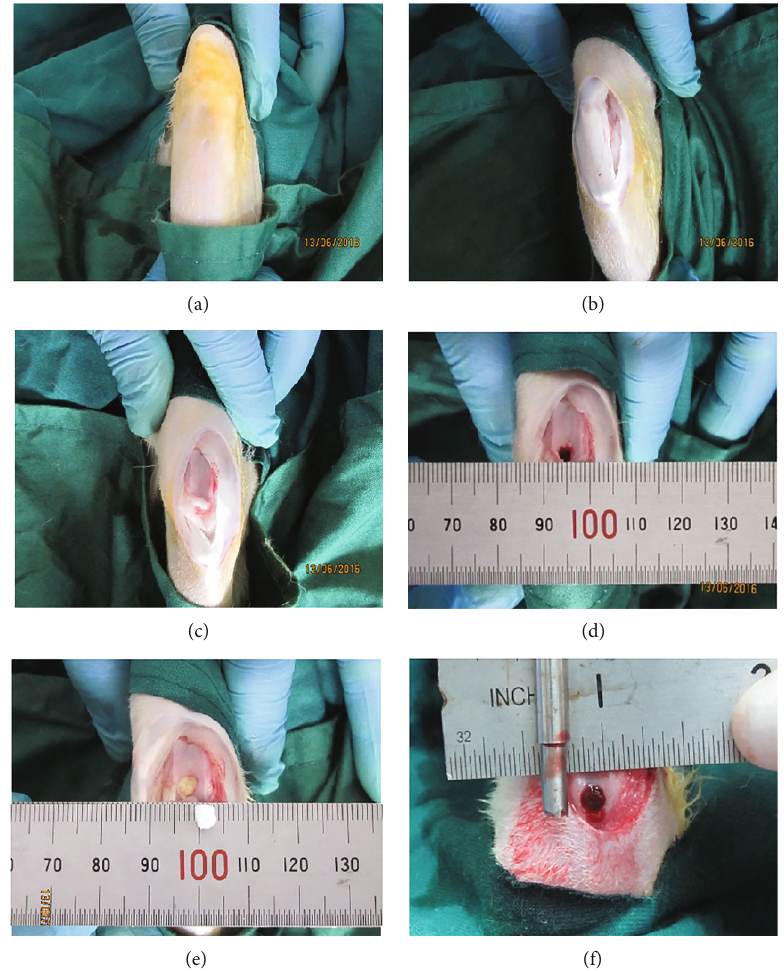
Figure 7: Modeling osteochondral defect and sca ff old implantation. (a) Skin preparation after routine anesthesia. (b) Medial patellar incision. (c) Exposure of femoral trochlea. (d) Femoral trochlea osteochondral defect was successfully modeled. Three-phase sca ff old (e) without and (f) with PDA treatment was